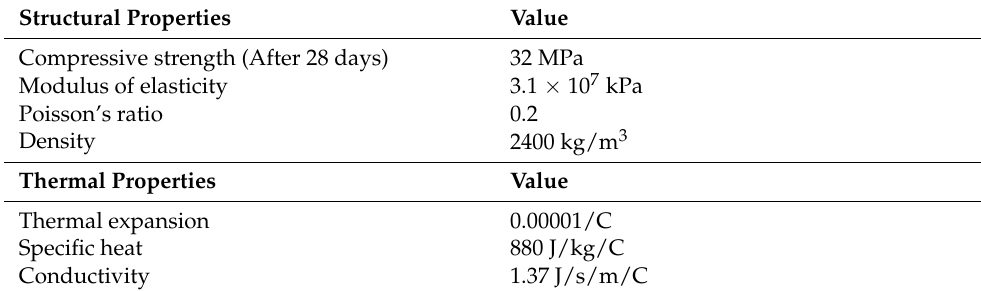
Table 5. Structural and thermal properties of concrete.